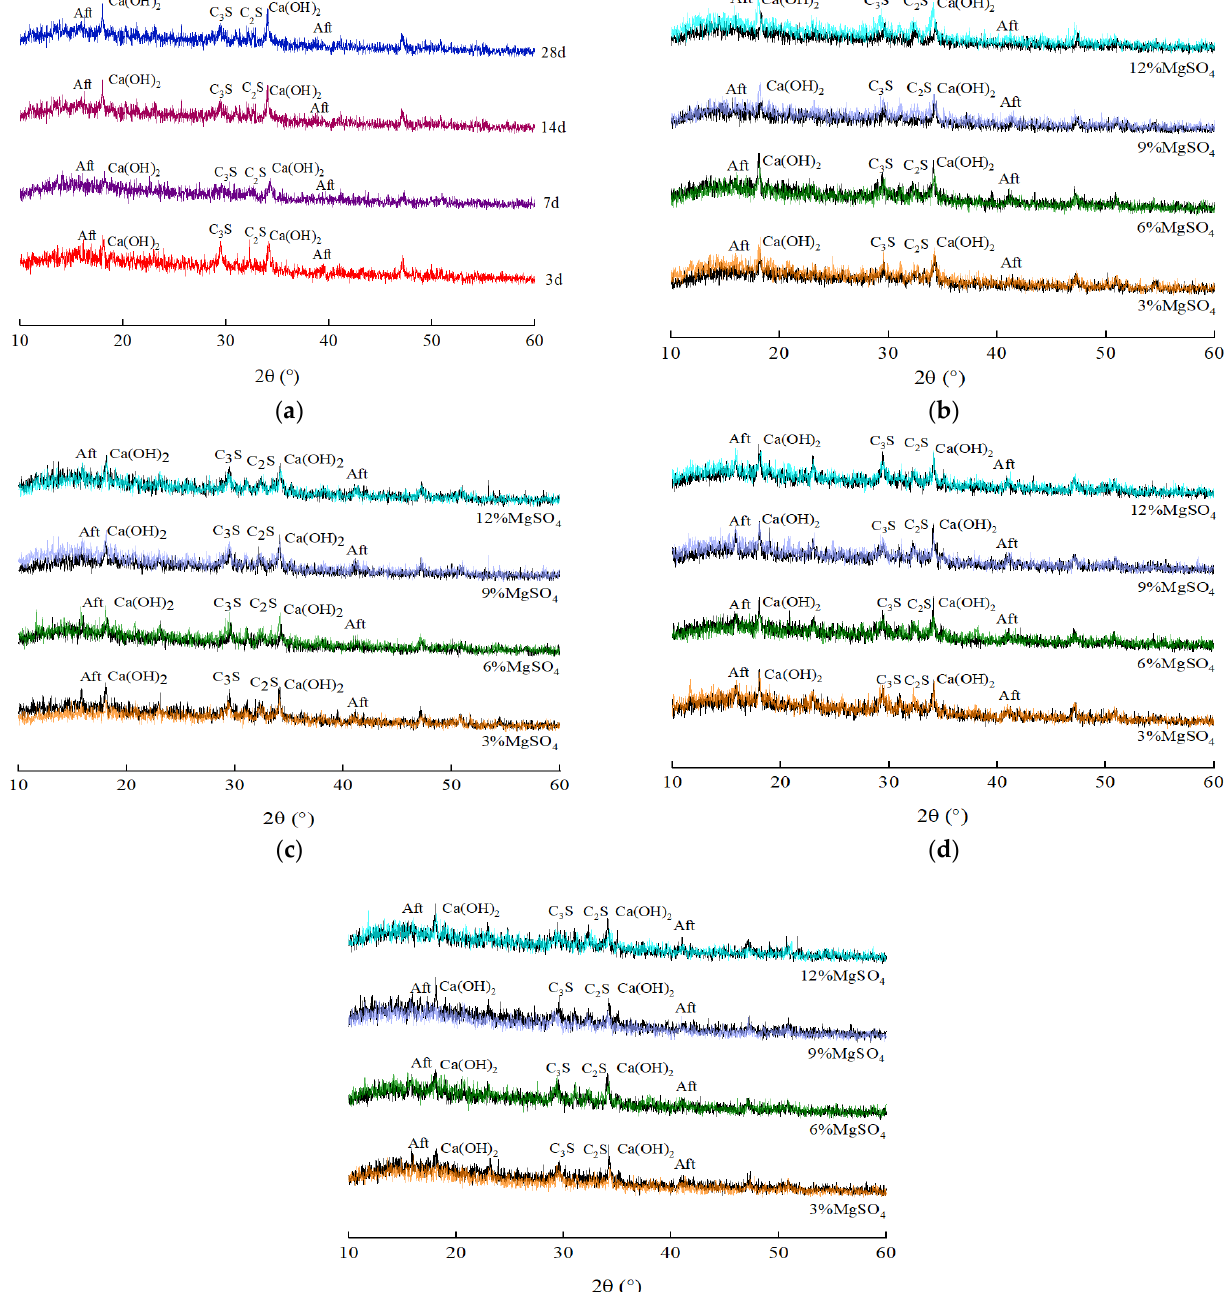
Figure 5. The diffraction pattern of the HECM: ( a ) Corrosion for 0-day; ( b ) Corrosion for 3 days; ( c ) Corrosion for 7 days; ( d ) Corrosion for 14 days; ( e ) Corrosion for 28 days. In order to quantitatively analyze the variation of CH crystal content and the hydration process of the HECM in the case of different corrosion conditions, the diffraction peak intensity of CH crystal is extracted. Figure 6 shows the variation curves of the diffraction peak intensity of CH crystals inside (IN) and outside (OU) the HECM with the change in testing age and MgSO 4 solution concentration.